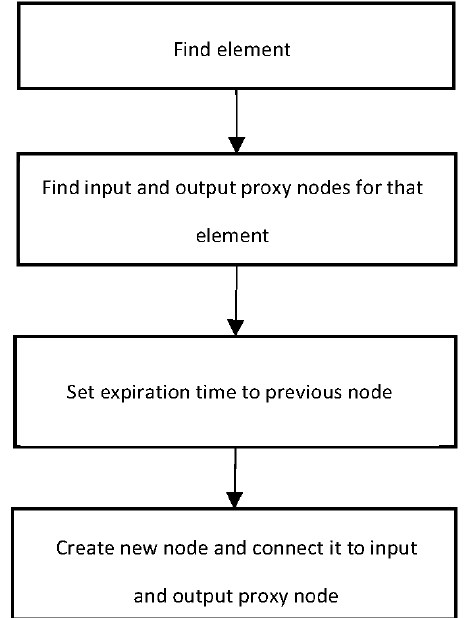
Figure 8. BDA adding a new value for the third approach.